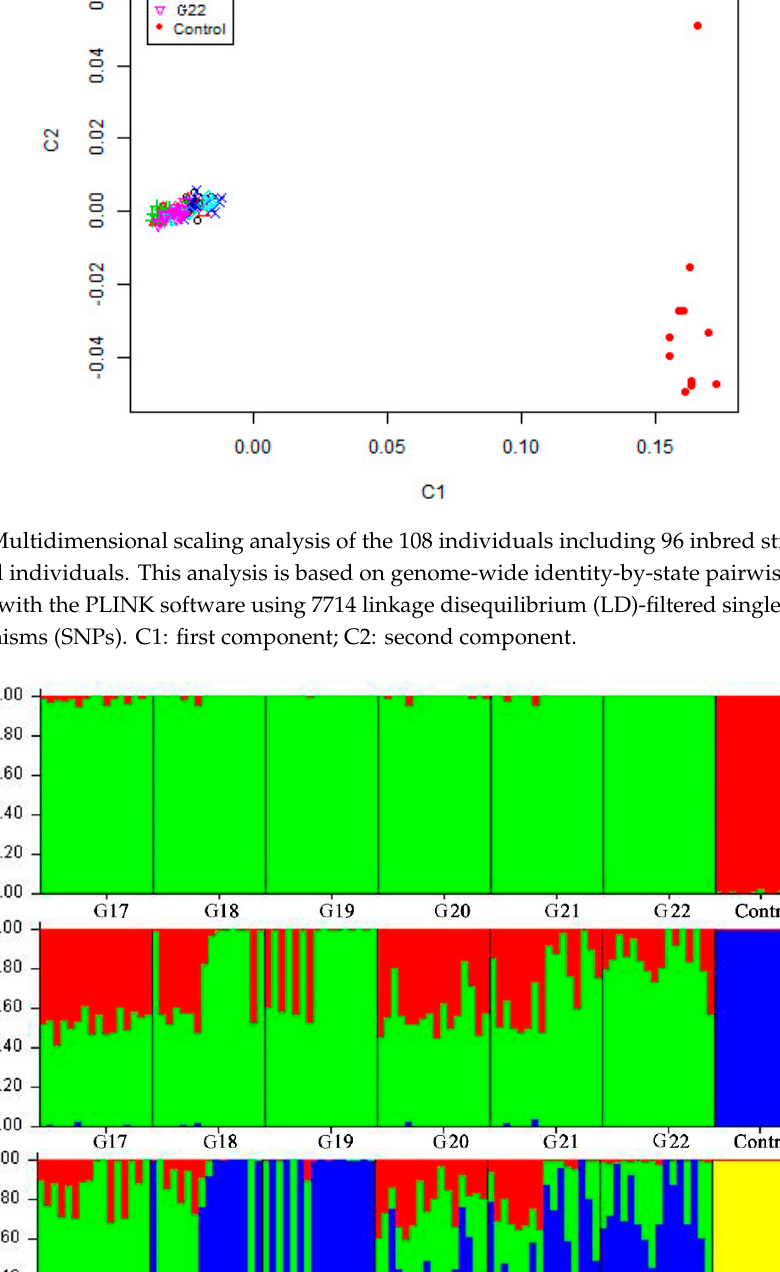
Figure 4. Neighbor-joining tree of the 96 inbred pigs and 12 non-inbred pigs. Individual and breed relationships among 108 pigs illustrated by genetic distances estimated using 7714 LD-filtered SNPs. 3.3. Runs of Homozygosity and ROH Regions across Generations